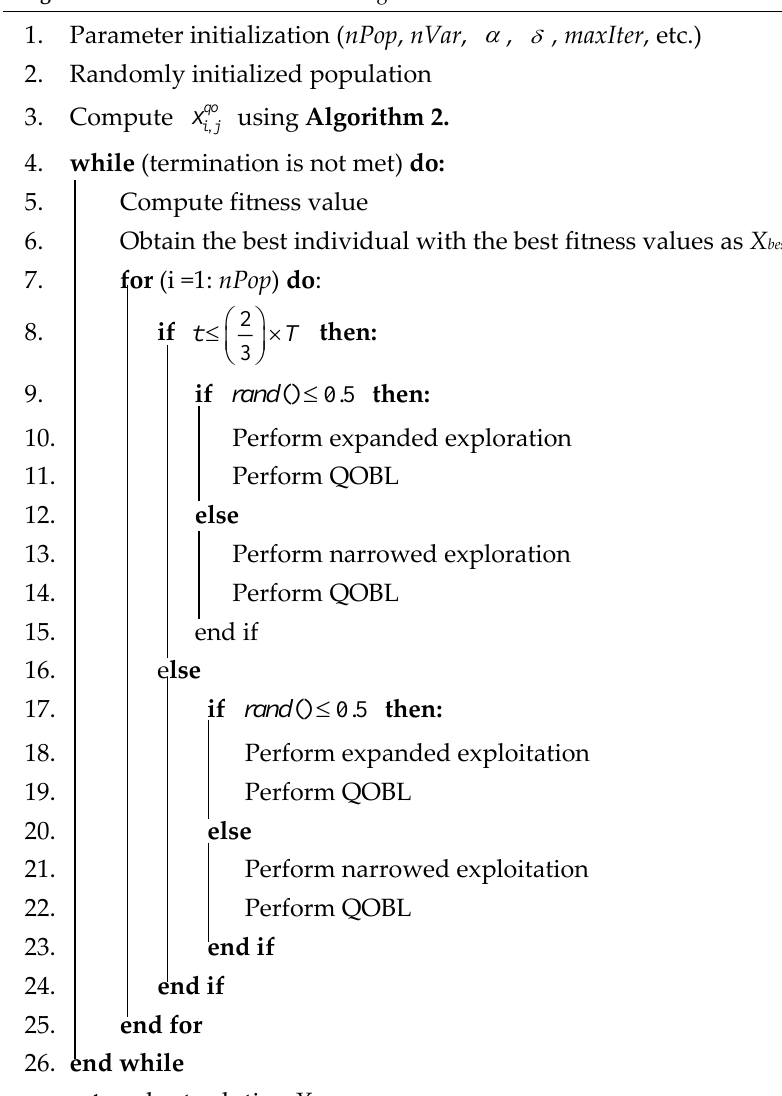
Algorithm 3: Pseudocode of the MAO algorithm